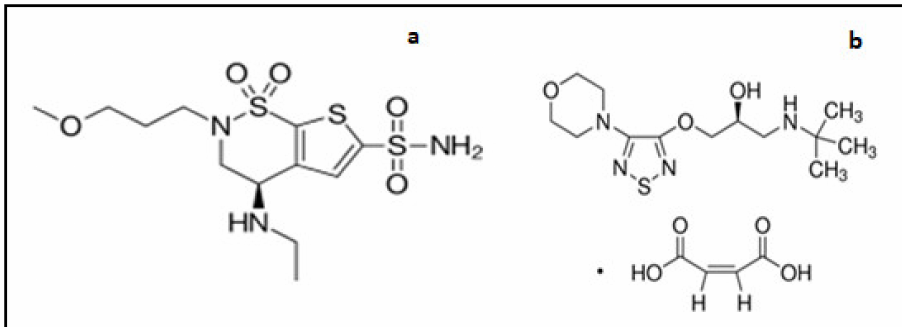
Figure 1. Chemical formula of brinzolamide ( a ) and chemical formula timolol maleate ( b